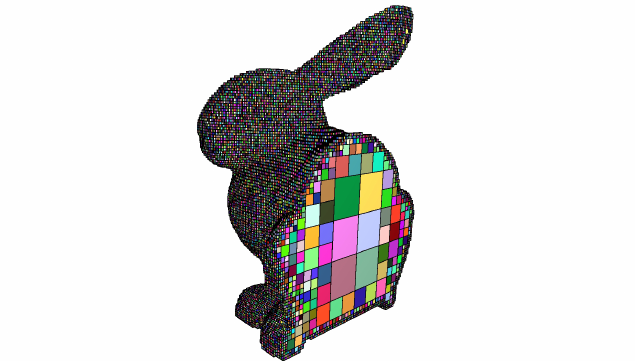
Figure 8. A block of a 3-dmap obtained by the hexahedral subdivision of Bunny . We can see hexahedra with different levels of